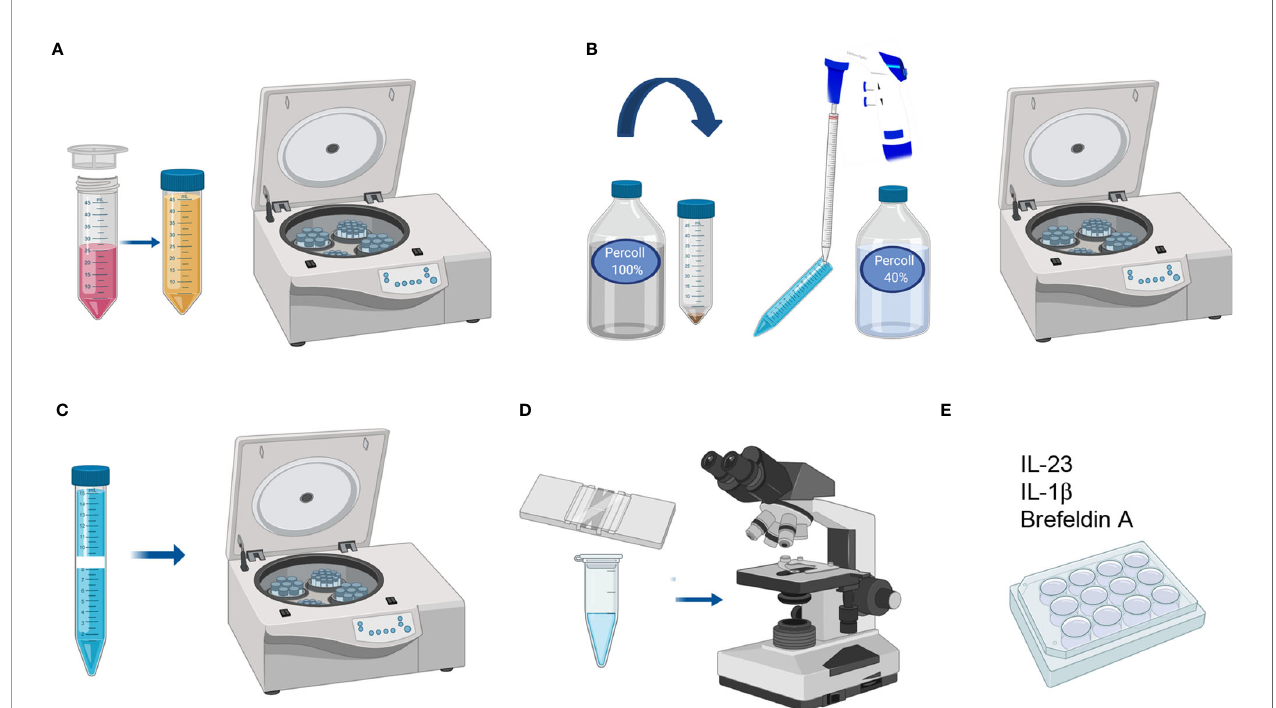
FIGURE 4 | LPC isolation from colon and small intestine. (A) Filtering uniformly digested pieces and cleaning with Colon Predigestion Medium. (B) 100 – 40% percoll gradient centrifugation. (C) Collecting the middle ring of white cells and washing with PBS 1X. (D) Counting the cells. (E) Culturing the single-cell suspension with IL-23, IL-1 b , and Brefeldin A for 4 h in a 24-well plate at 37°C in a CO2